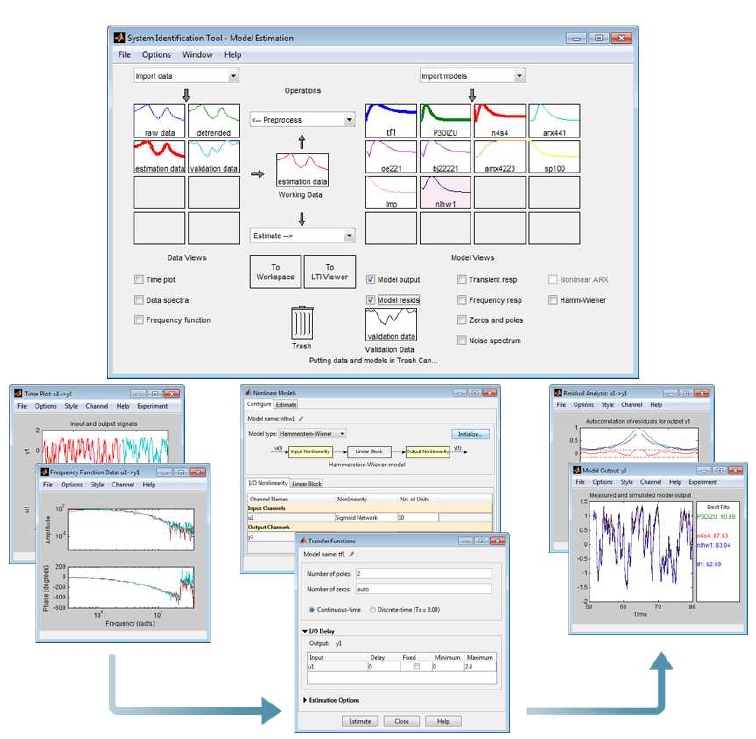
Figure 3. Graphical user interface of “ident”, a part of the System identification Matlab-Toolbox r